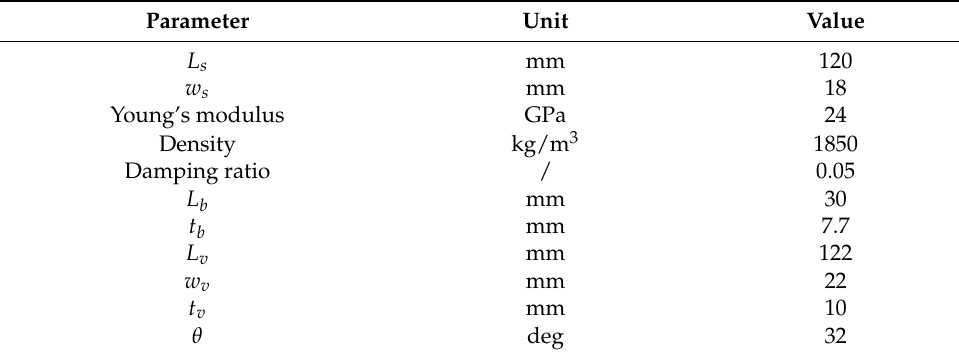
Table 3. Geometrical and mechanical parameters of the piezoelectric cantilever harvester.